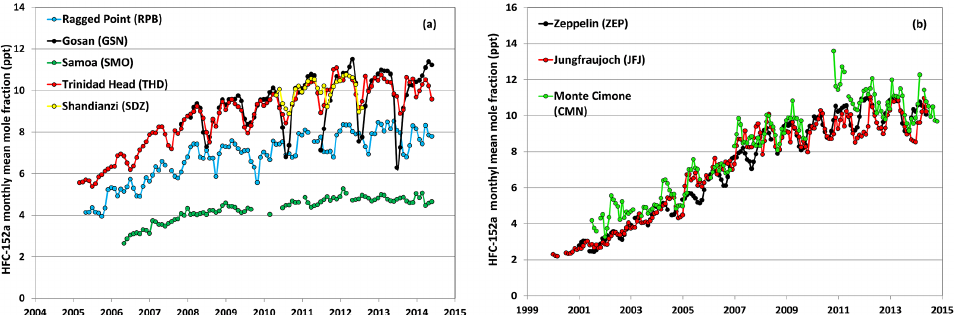
Figure 4. (a) Medusa GC-MS baseline monthly mean mole fractions (ppt) recorded at Ragged Point, Gosan, Cape Matatula, Trinidad Head, and Shangdianzi. Observations at Shangdianzi were discontinued in August 2012. (b) Combined ADS and Medusa GC-MS baseline monthly mean mole fraction recorded at Ny-Ålesund, Jungfraujoch, and Monte Cimone.